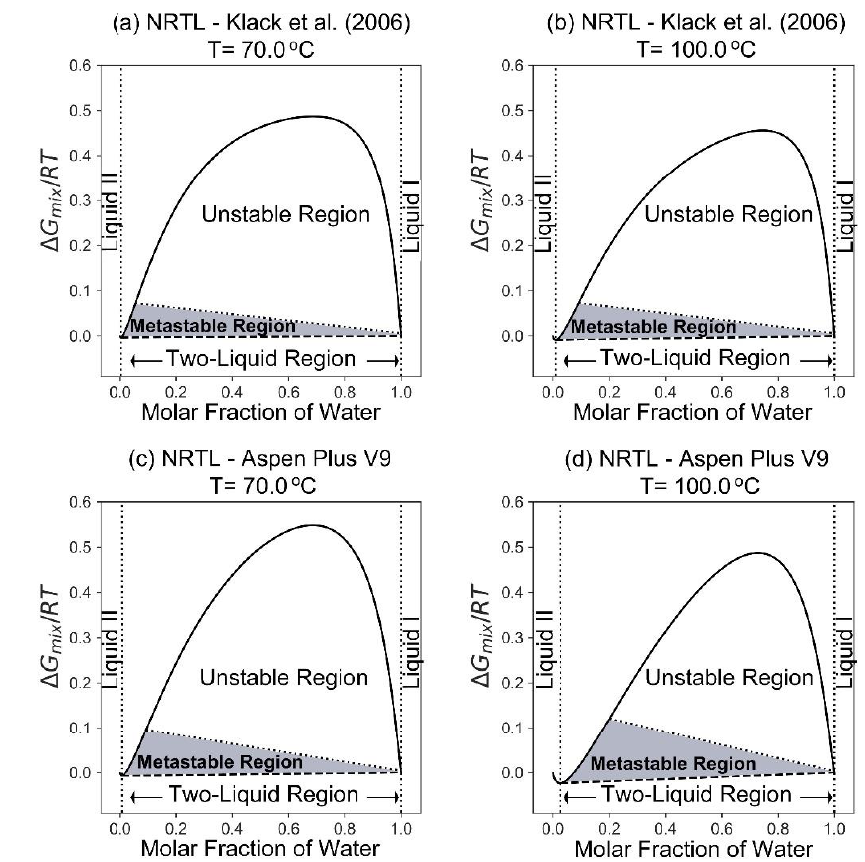
Figure 5. Unstable and Metastable Liquid–Liquid Equilibrium Regions for a Water/n-Octane Blends using: ( a , b ) Klauck et al. parameters [30] and ( c , d ) Aspen Plus V9 parameters. Parameters reprinted with permission from Klauck, M.; Grenner, A.; Schmelzer, J. Liquid–liquid(–liquid) equilibria in ternary systems of water + cyclohexylamine + aromatic hydrocarbon (toluene or propylbenzene) or aliphatic hydrocarbon (heptane or octane). J. Chem. Eng. Data, 2006, 51 , 1043– 1050, doi:10.1021/je050520f. Copyright 2021 American Chemical Society.